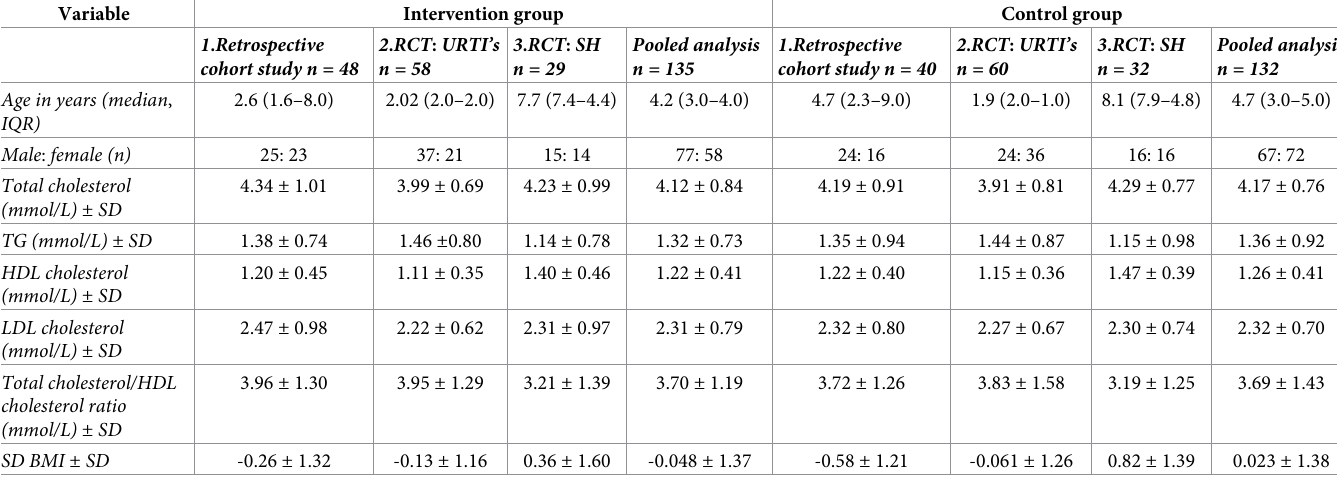
Table 2. Baseline characteristics and measurements of the lipid profile of the intervention group and control group of the three intervention study’s and combined for the pooled analysis. Variable Intervention group Control